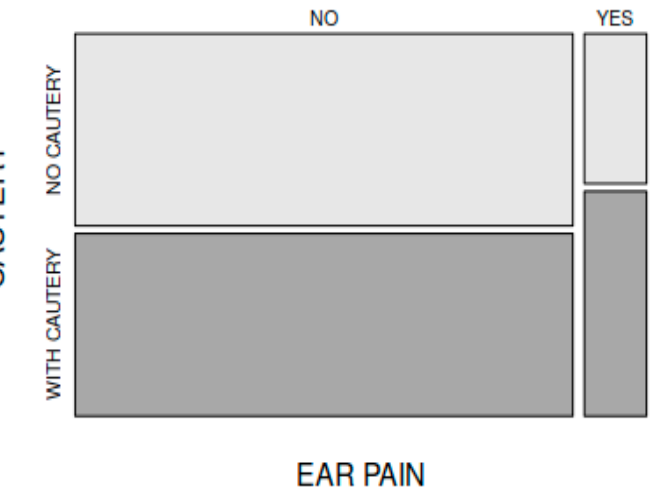
Figure 4. Incidence of postoperative ear pain was similar regardless of electrocautery use. In comparing the frequency of postoperative posterior headache (neck pain) encoun- tered in the patients from group A (34 out of 45 patients) to that of the patients in group B (2 out of 45 patients), there was a statistically significant difference between the groups (X-squared = 44.491, df = 1, p < 0.001). Postoperative neck pain (pain at the back of the